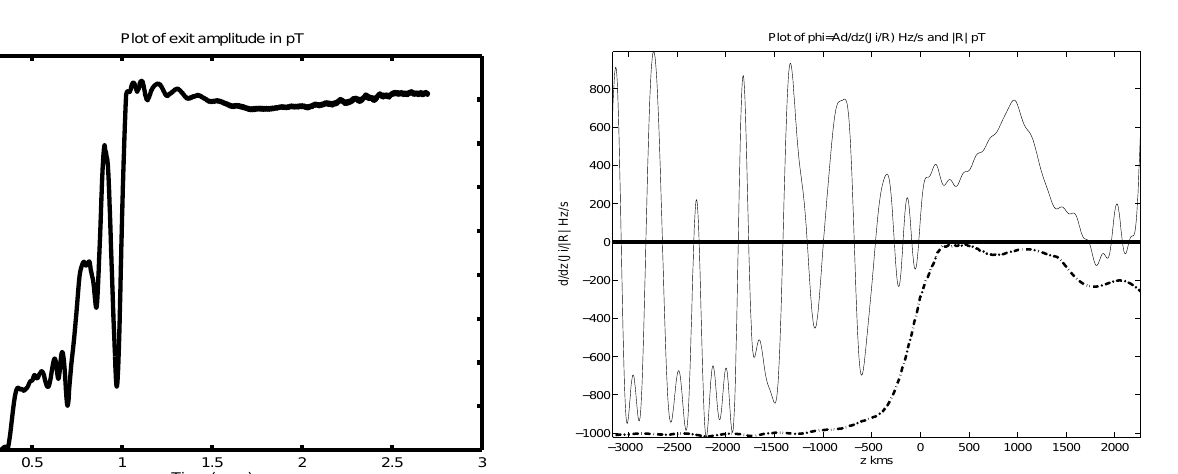
Fig. 7. Run 1. Wave amplitude at the exit from the simulation box as a function of time; note the build up over 1/2s, and then saturation at t = 1 . 215s.